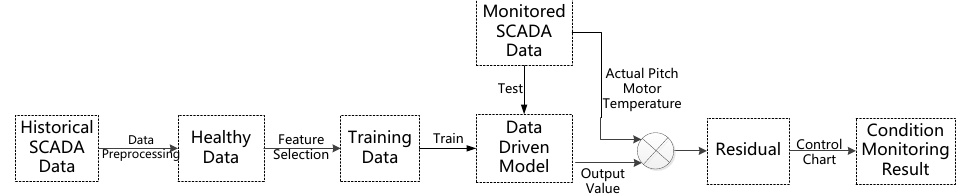
Figure 2. The framework of the data-driven model.